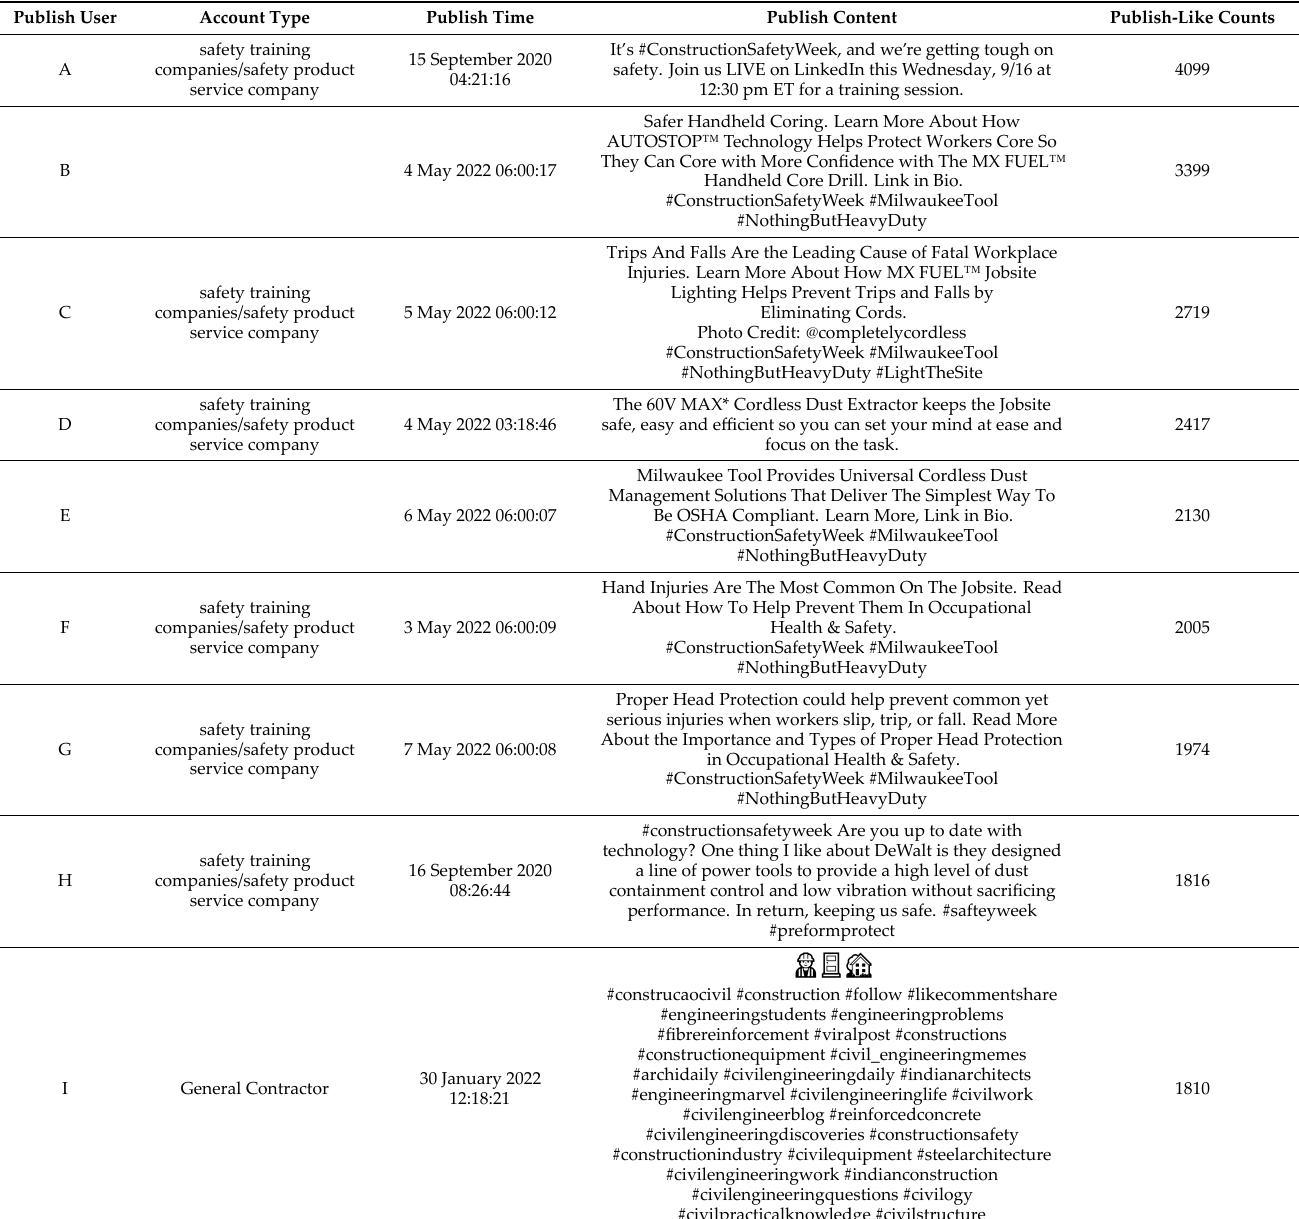
Table 2. Influential content with more likes in IG construction health and safety